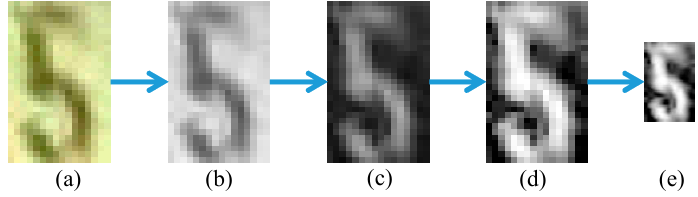
Figure 16. Step-by-step preprocessing of training data: ( a ) Manually cropped RGB image, ( b ) gray-scale image, ( c ) complemented image, ( d ) histogram equalized image, and ( e ) resized image.